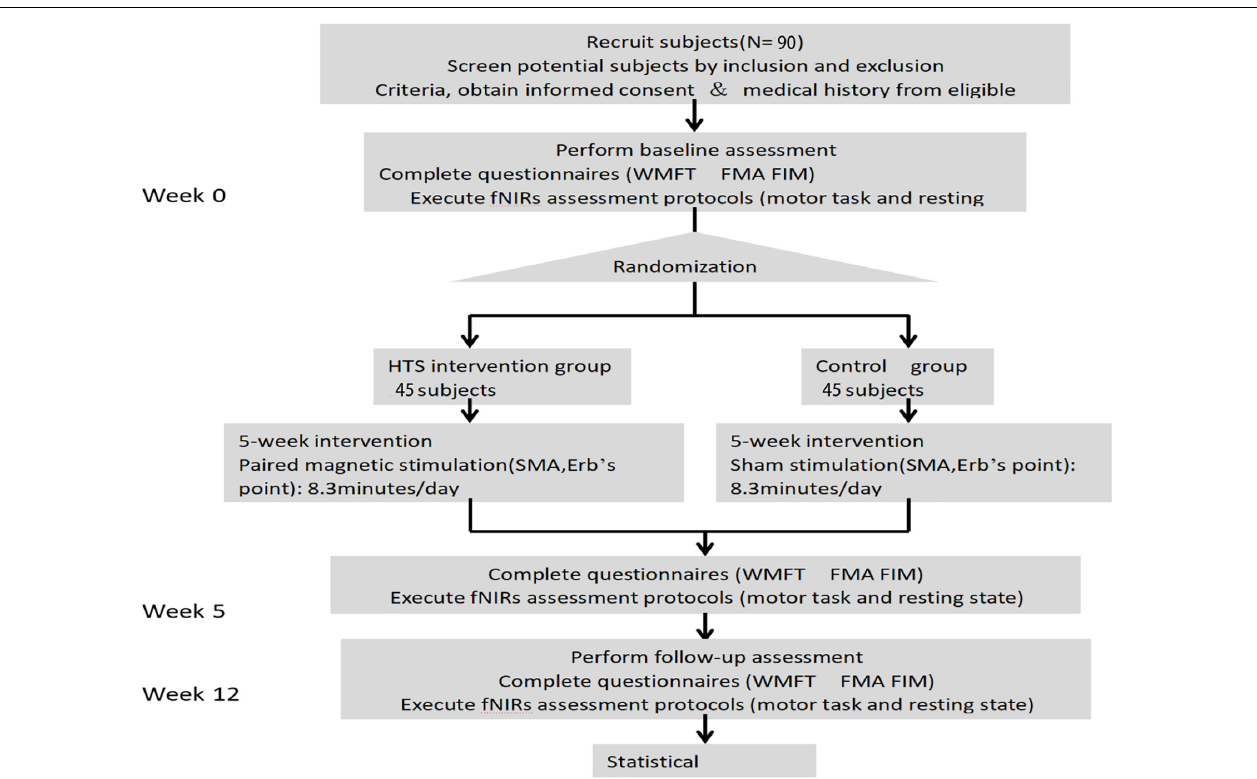
FIGURE 2 | Overview of study